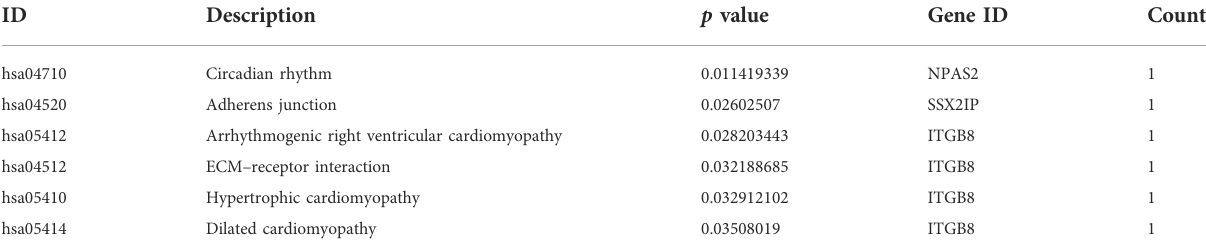
TABLE 3 KEGG analysis of ceRNA